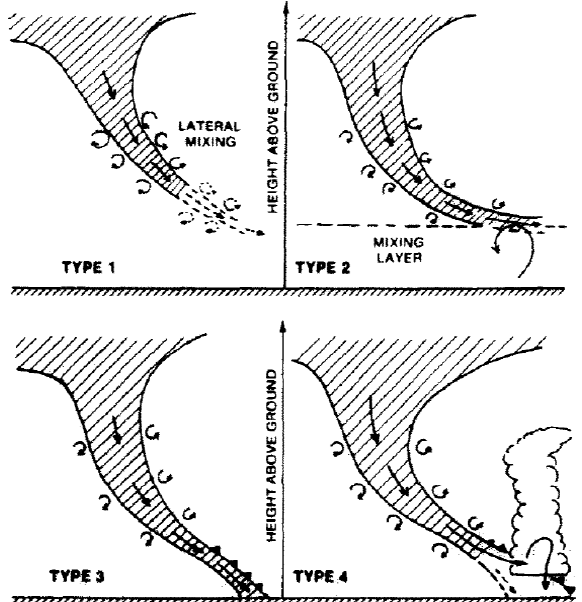
Figure 1. Schematic representation of four mechanisms bringing stratospheric air into the lower troposphere and potentially down to the surface (from Johnson and Viezee, 1967; their Fig. 10; repro- duced with permission from